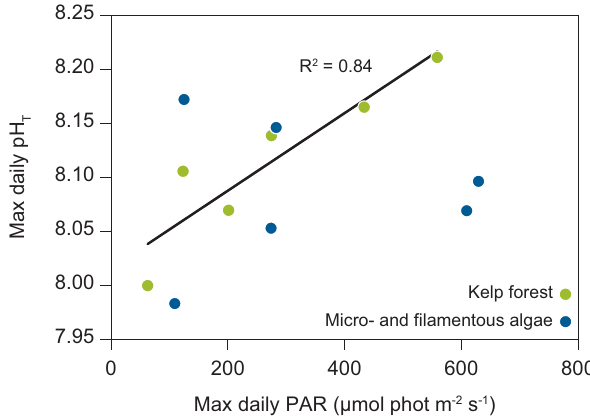
Figure 5. Maximum daily pH in a kelp forest (green dots) and above microalgae/filamentous algae (blue dots) as a function of maximum daily incident light over 6 full days as measured during three par- allel deployments in Kobbefjord, Nuuk, 27–30 August, 30 August– 2 September, and 2–5 September 2013. Linear fit and coefficient of determination are shown for the significant relationship for the kelp forest.